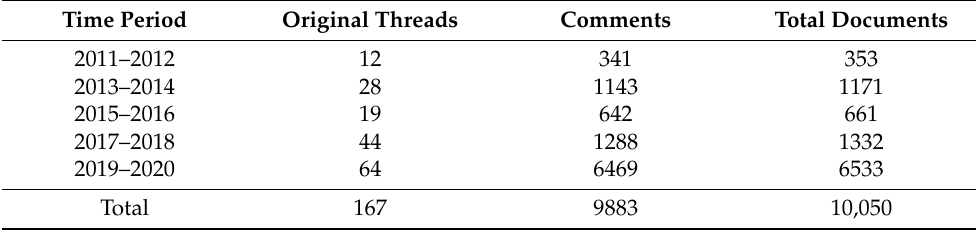
Table 1. Summary of final